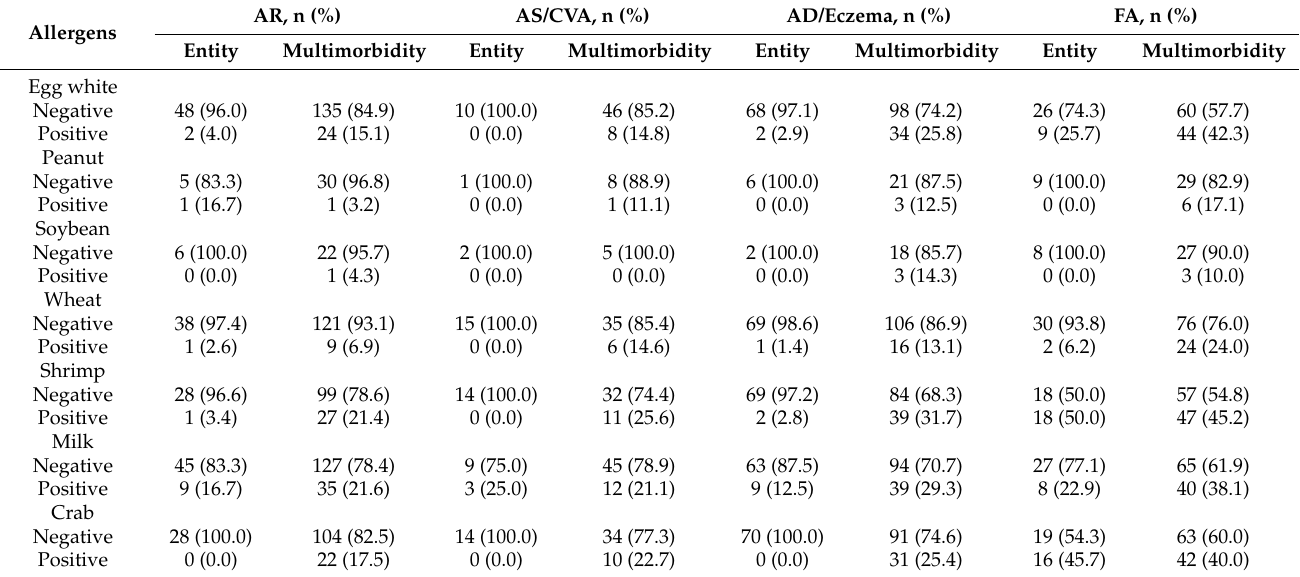
Table 4. Comparison of ingested allergen sensitization between allergic multimorbidities against a single entity in four allergic